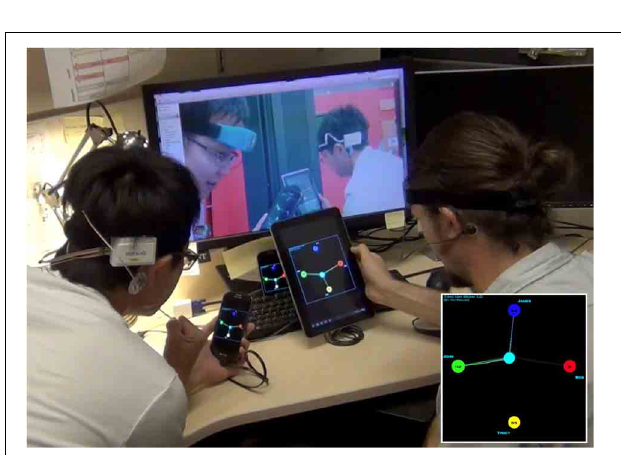
FIGURE 7 | An EEG Tractor Beam game session with four people playing over the Internet: two players at SCCN in San Diego, USA are shown in the foreground while two other players at NCTU in Hsinchu, Taiwan appear in the monitor display. The inset at the lower right corner shows a captured view of the game